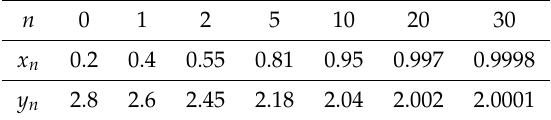
Table 20. Values of the iterated sequence ( x n , y n ) if started with ( 0.2,2.8 ) .